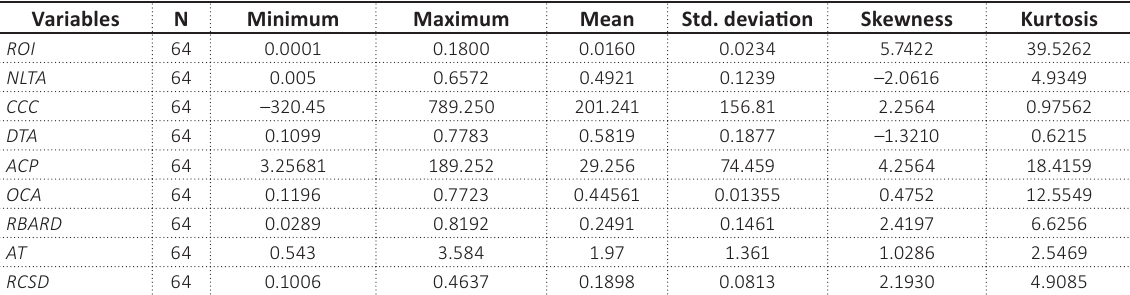
Table 3. Descriptive statistics